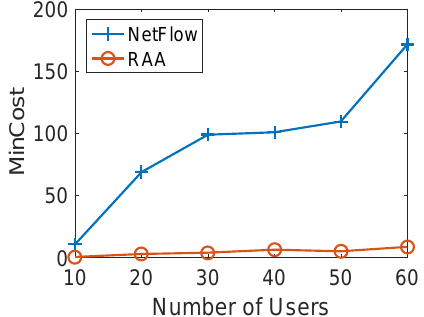
Figure 11. Mincost with non-uniform distribution.